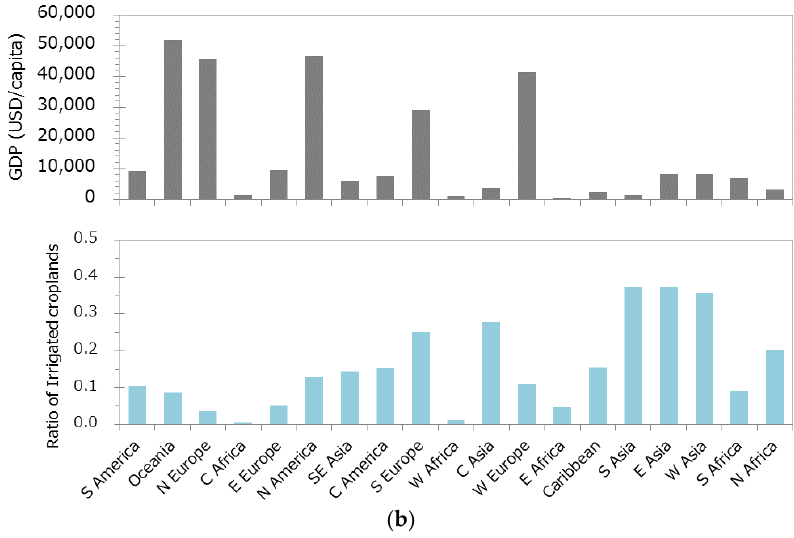
Figure 4. ( a ) The net import of the water footprint inventory and water scarcity footprint and ( b ) the GDP per capita for 2010 and the ratio of irrigated cropland to total cropland by region.